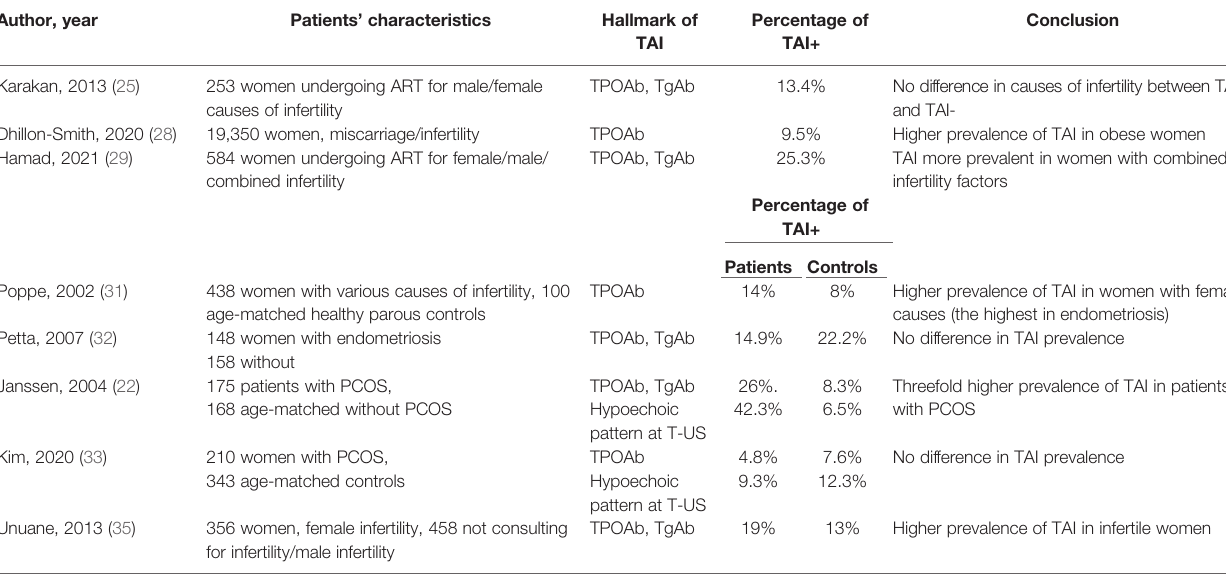
TABLE 1 | Prevalence of thyroid autoimmunity in infertile